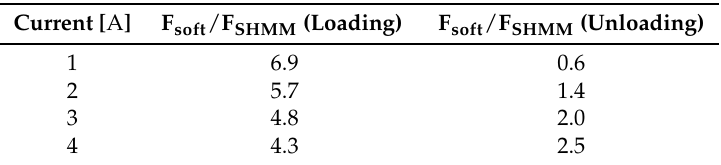
Table 4. Ratio between the forces generated at 0.55 mm air gap by the electromagnet based on the soft and the semi-hard magnetic material,